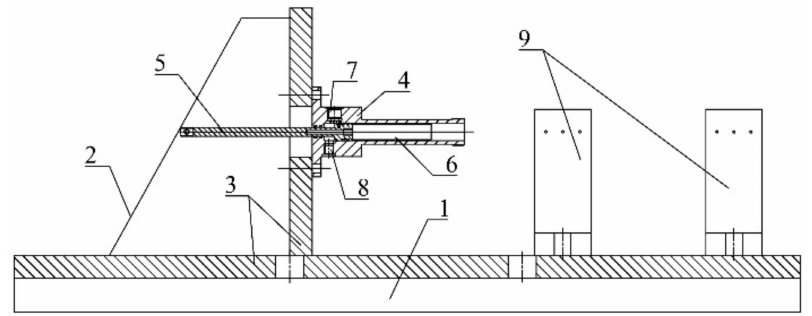
Figure 12. Cross-sectional view of the pin-rod type of measuring device. 1—base, 2—rib plate, 3—bracket, 4—shell body of pin puller, 5—pin-rod, 6—additional mass, 7—pressure transducer port, 8—cartridge port, 9—photoelectric target